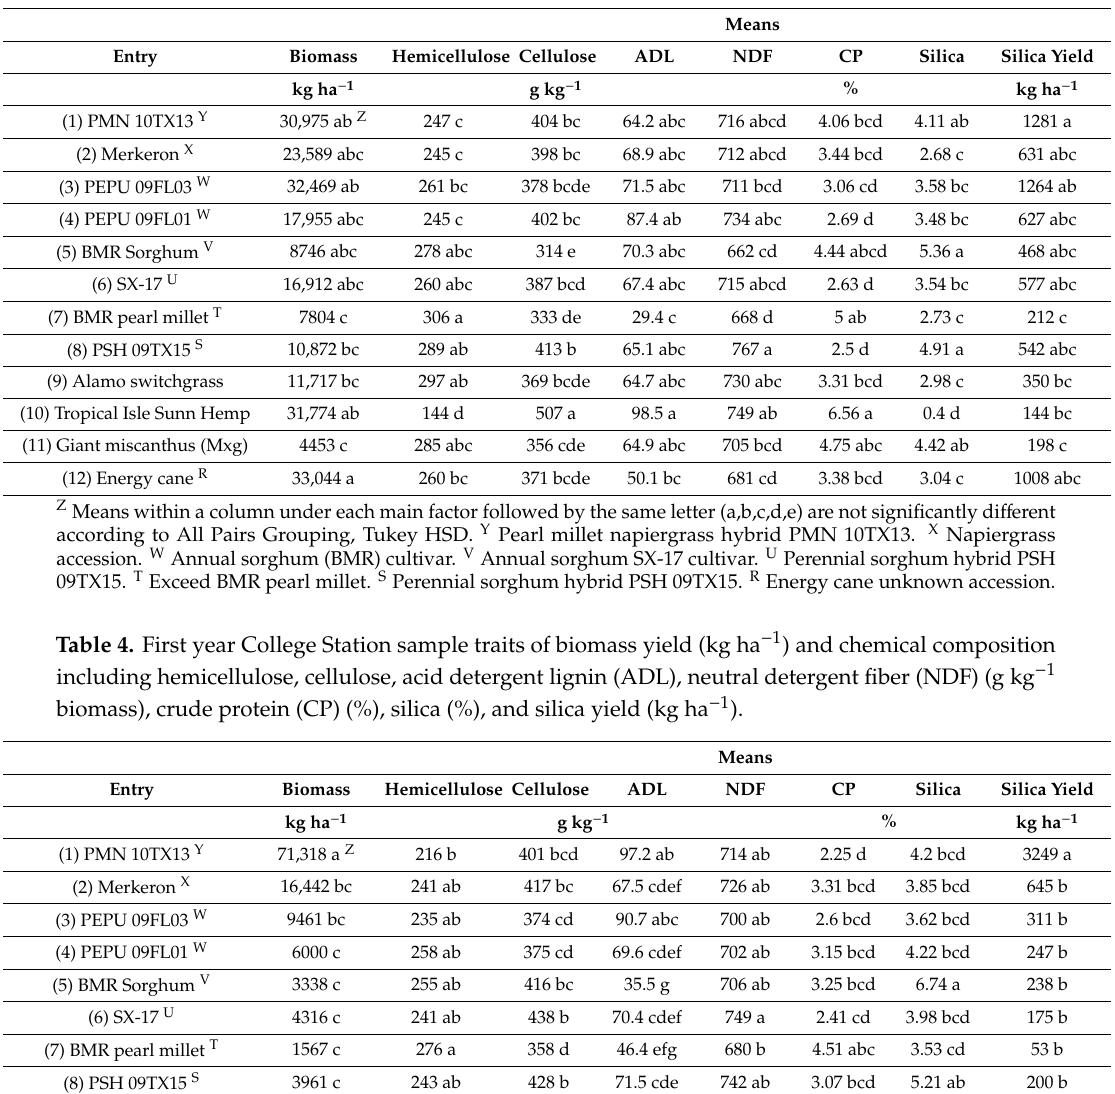
Table 3. First year Stephenville sample traits of biomass yield (kg ha − 1 ) and chemical composition including hemicellulose, cellulose, acid detergent lignin (ADL), neutral detergent fiber (NDF) (g kg − 1 biomass), crude protein (CP) (%), silica (%), and silica yield (kg ha − 1 ).